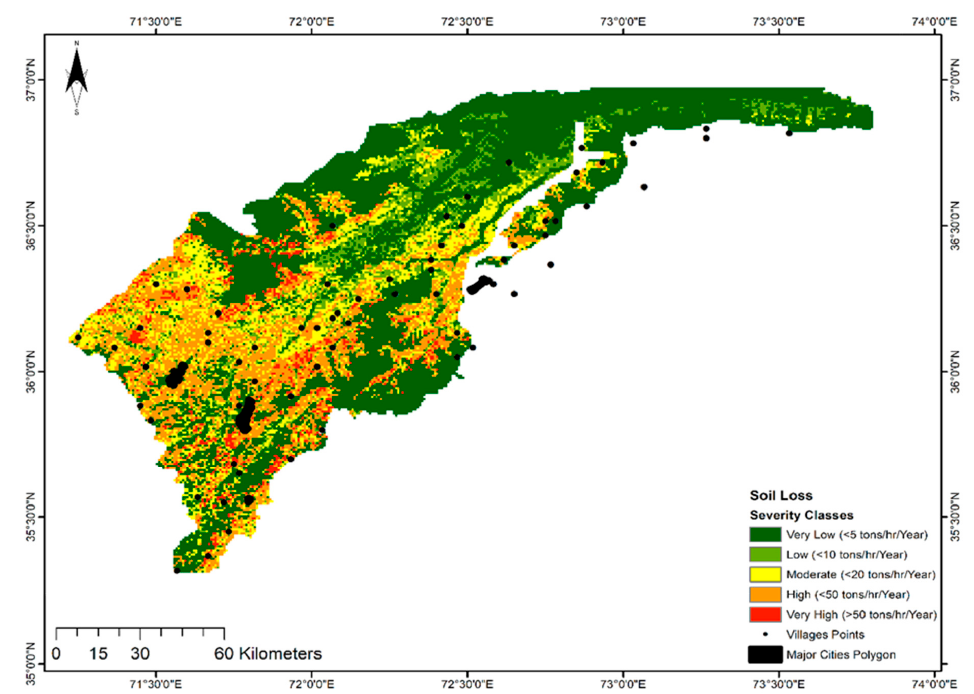
Figure 7. District map for severity classes.